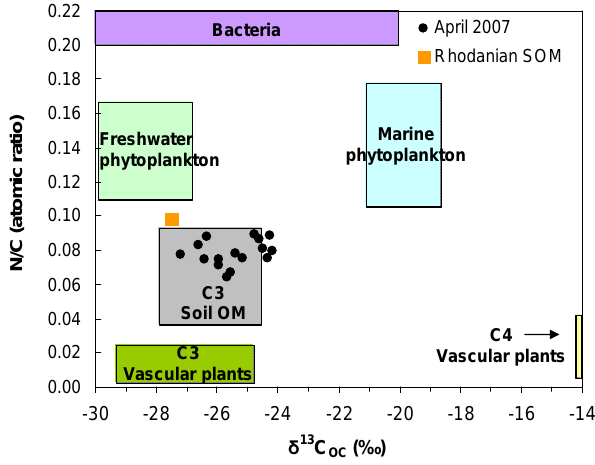
Fig. 7. Plot of atomic organic nitrogen:carbon ratios (N/C (atomic ratio)) versus the stable carbon isotopic compositions ( δ 13 C OC ) of surface sediments and suspended organic matter (SOM) from the Rhˆone River. Also plotted are the compositional ranges of poten- tial end-member sources from the literature (Harmelin-Vivien et al., 2008; Melillo et al., 1989; Von Fischer and Tieszen, 1995; Vuorio et al., 2006; Go˜ni and Thomas, 2000; see citations in Meyers, 1994; and Maksymowska et al., 2000). In this diagram, N/C was plotted rather than its reciprocal because this ratio is statistically more ro- bust and allows us to plot two parameters that are essentially carbon normalized (N/C and 13 C/ 12 C ratios, Go˜ni et al., 2005; Lansard et al.,